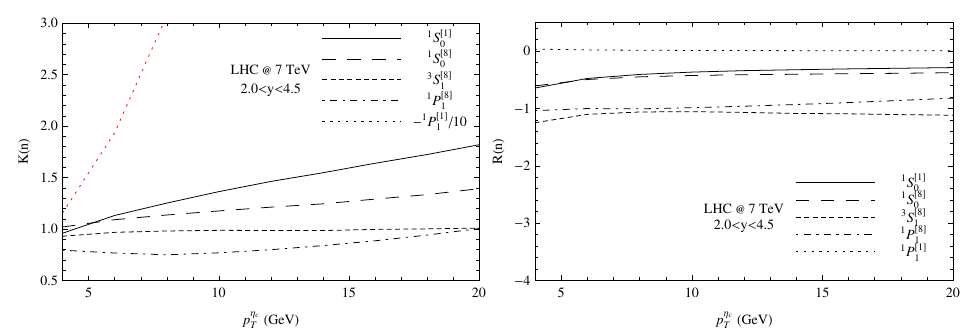
Figure 1. Ratios K ( n ) = d σ c ¯ c [ n ]